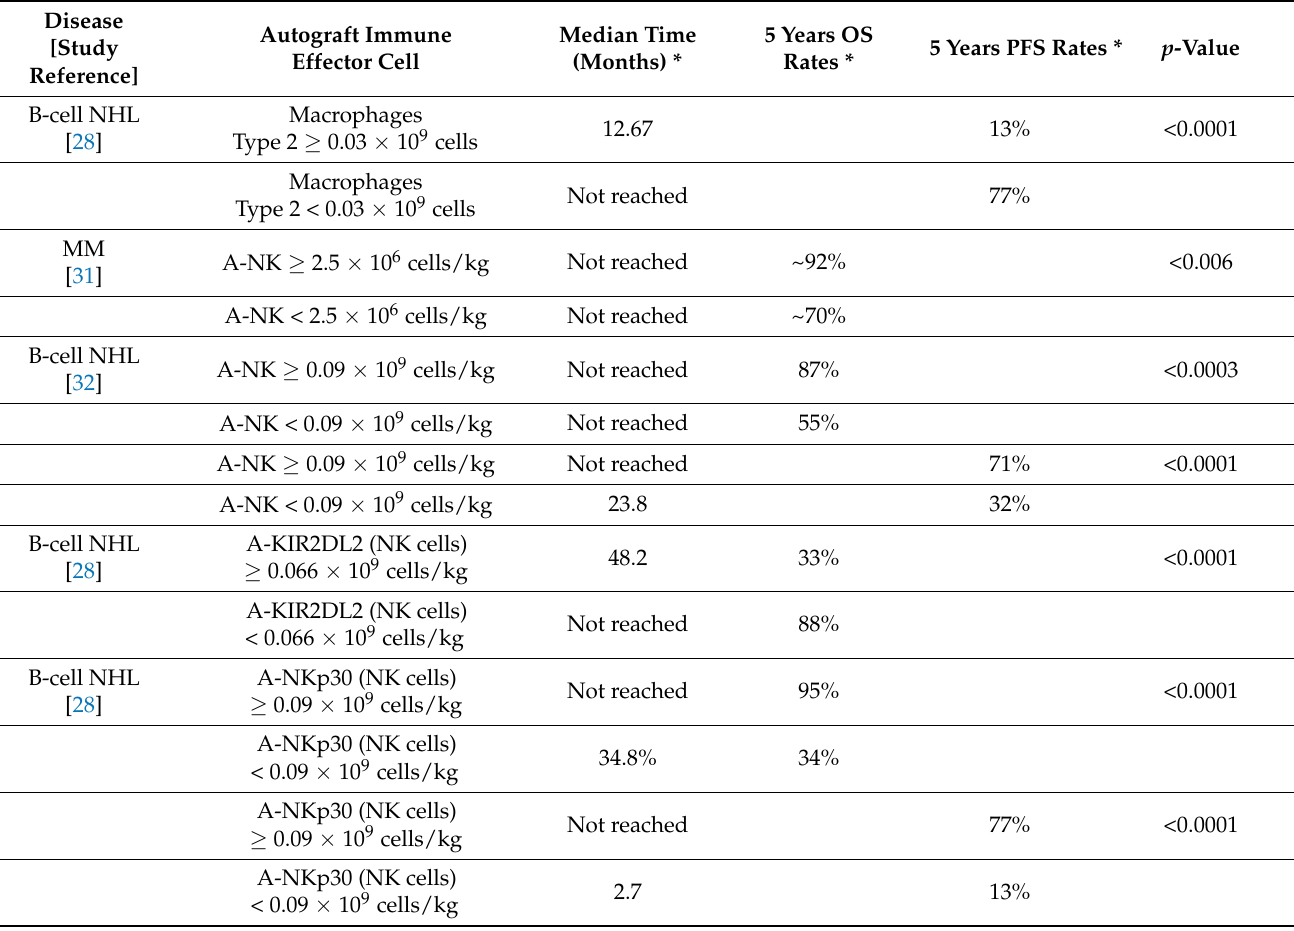
Table 3. Clinical outcomes post-autologous stem cell transplantation based on the infusion of autograft-innate immune system